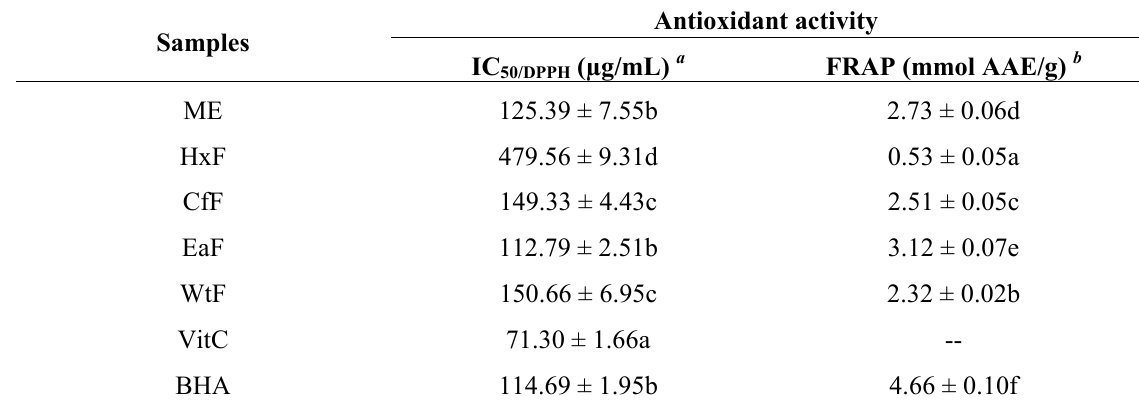
Table 2. Antioxidant activities of the methanolic extract (ME) of leaves of S . cumini and its fractions using the (DPPH) free radical-scavenging assay and the (FRAP) ferric- reducing antioxidant power assay (n =